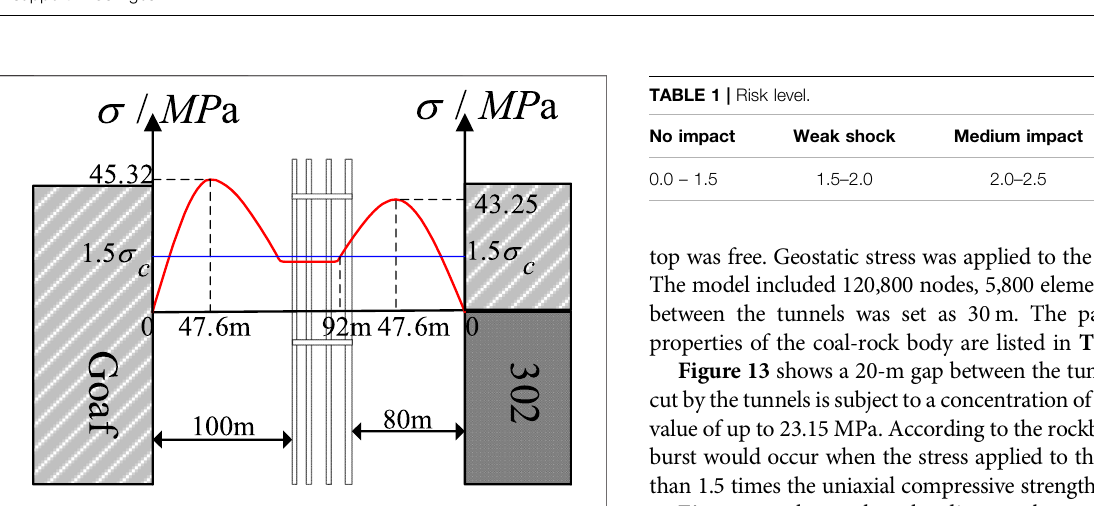
FIGURE 11 | Stress distribution diagram of lateral support. (A) Stress distribution of lateral support in 204 205 206 goaf, and (B) Stress distribution of lateral support in 302 goaf